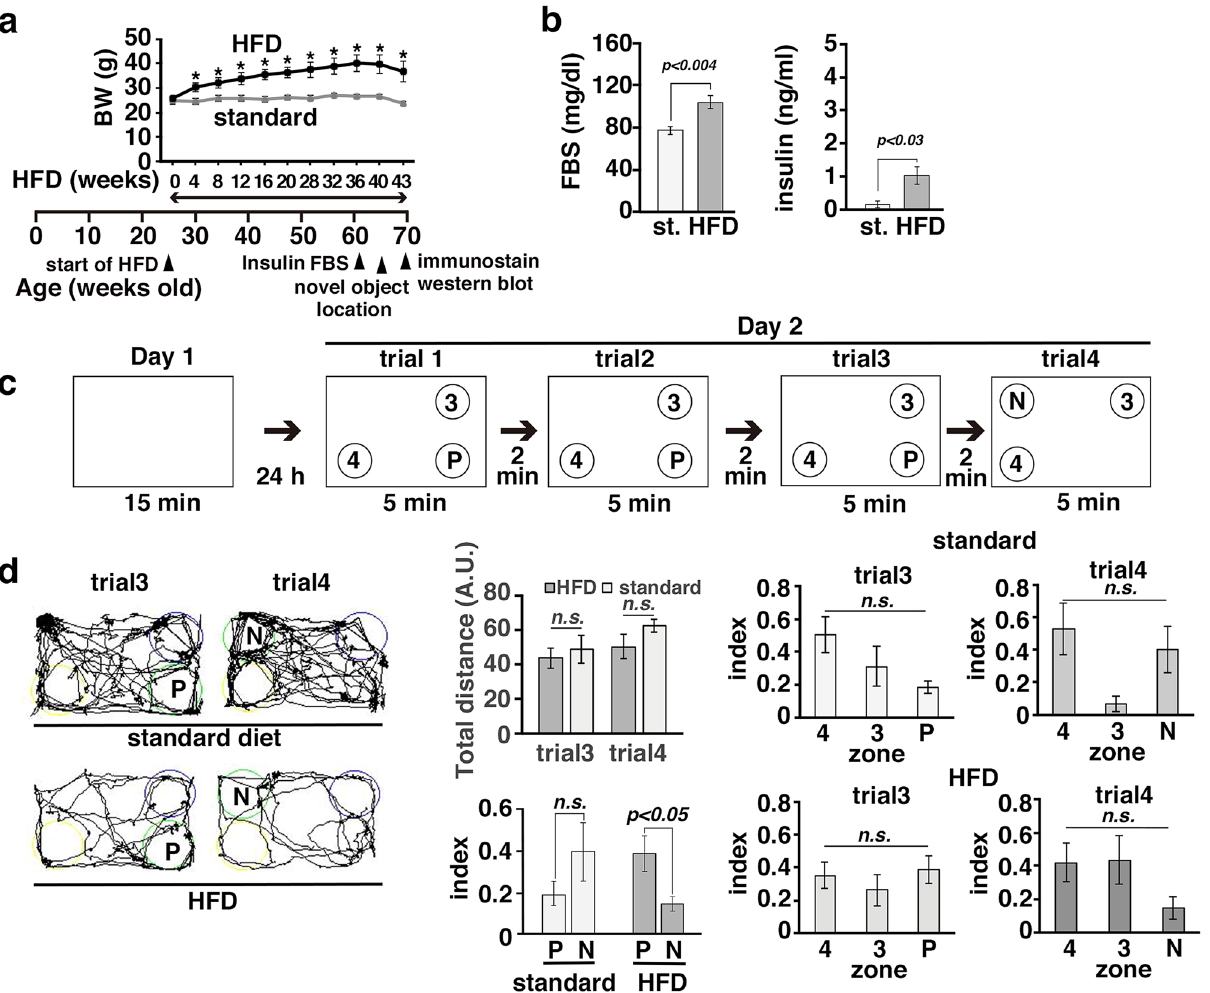
Figure 1. Memory was impaired in aged mice with long-term obesity. ( a – d ) APP23 mice (25 to 27 weeks old) were fed a standard chow diet (st) or a HFD (60% fat) for 43 weeks. The body weights (BWs) of APP23 (n = 7 standard diet-fed mice; n = 9 HFD-fed mice) ( a ) mice. The error bars represent the standard errors of the mean (SEMs). * p < 0.05 . Statistical significance ( p < 0.05) was determined by Student’s t test. ( b ) Serum levels of FBS and insulin in standard diet-fed mice (n = 5) and HFD-fed mice (n = 8). Statistical significance ( p < 0.05) was determined by Student’s t test. ( c ) Performances of mice with long-term obesity and control mice in the NOL test. One of three objects was moved from the previous location (P) to a novel location (N). ( d ) Representative trajectories of mice exploring the objects (left panels). The total distance traveled (arbitrary units: A. U.) and the exploration indices in each zone at trials 3 and 4 are shown. Statistical significance ( p < 0.05) was determined by Student’s t test (total distance; index comparing between zones P and N) or one-way ANOVA followed by the Bonferroni post-hoc test [standard diet-fed APP23 mice: F(2,12) = 2.76, p = 0.10 (trial3), F(2,12) = 3.62, p = 0.06 (trial4); HFD-fed APP23 mice: F(2,24) = 0.54, p = 0.59 (trial3), F(2,24) = 2.07, p = 0.15 (trial4)]. Standard diet-fed mice (n = 5); HFD-fed mice (n =